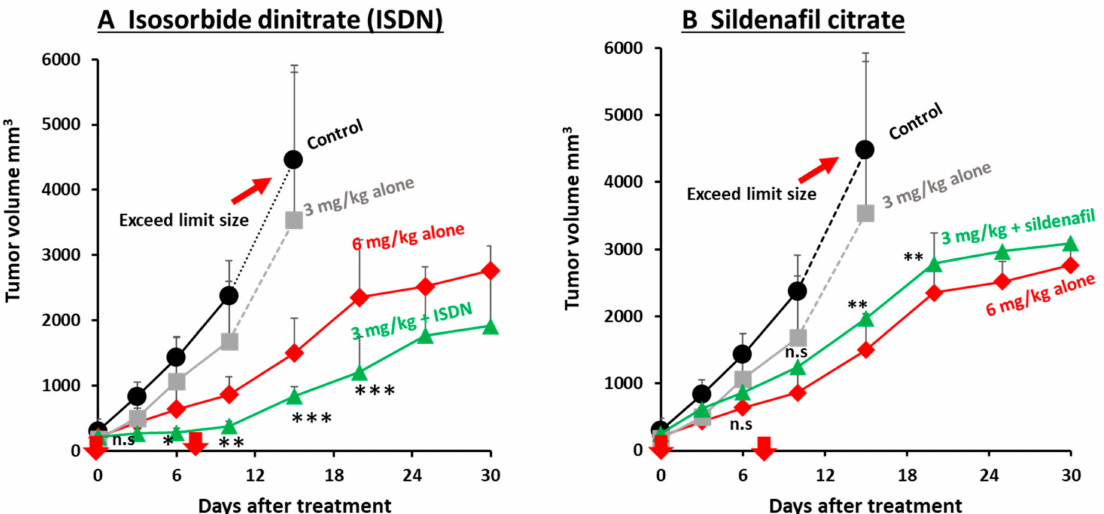
Figure 4. Improvement in the therapeutic effect of different concentrations of Smaplatin ® by using ISDN ( A ) and sildenafil ( B ) in C26 tumors. When tumor diameters measured about 12 mm, 6 mg/kg or 3 mg/kg Smaplatin ® was injected iv; ISDN (30 mg/kg, ip) or sildenafil (30 mg/kg sc) was given with 3 mg/kg Smaplatin ® . The 3 mg/kg Smaplatin ® given with ISDN showed improved therapeutic efficacy compared with 6 mg/kg Smaplatin ® given alone ( A ); the result for 3 mg/kg Smaplatin ® plus sildenafil was similar to that for 6 mg/kg Smaplatin ® given alone ( B ). Arrows indicate times of drug administration. * p < 0.05, ** p < 0.01, *** p < 0.001, combination group vs Smaplatin ® 3 mg/kg group. Data are expressed as means ± SD. ( n = 5